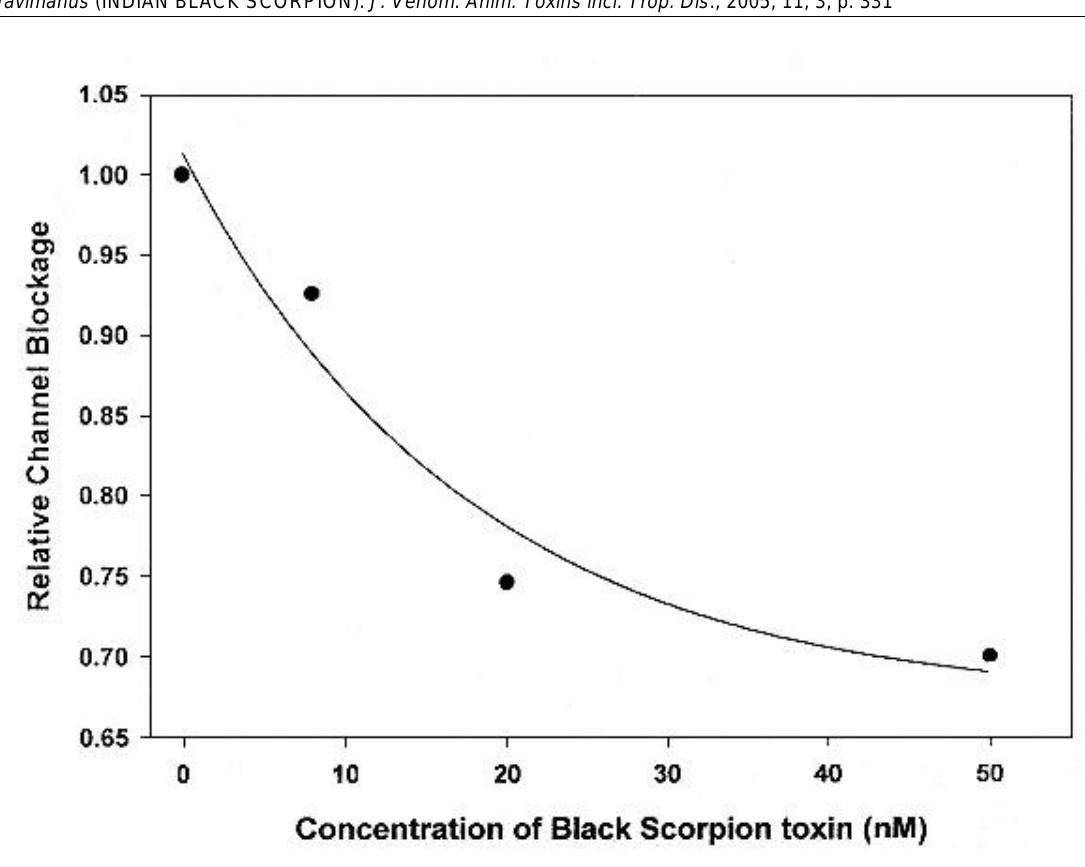
Figure 6e: Channel blockage as a function of the toxin